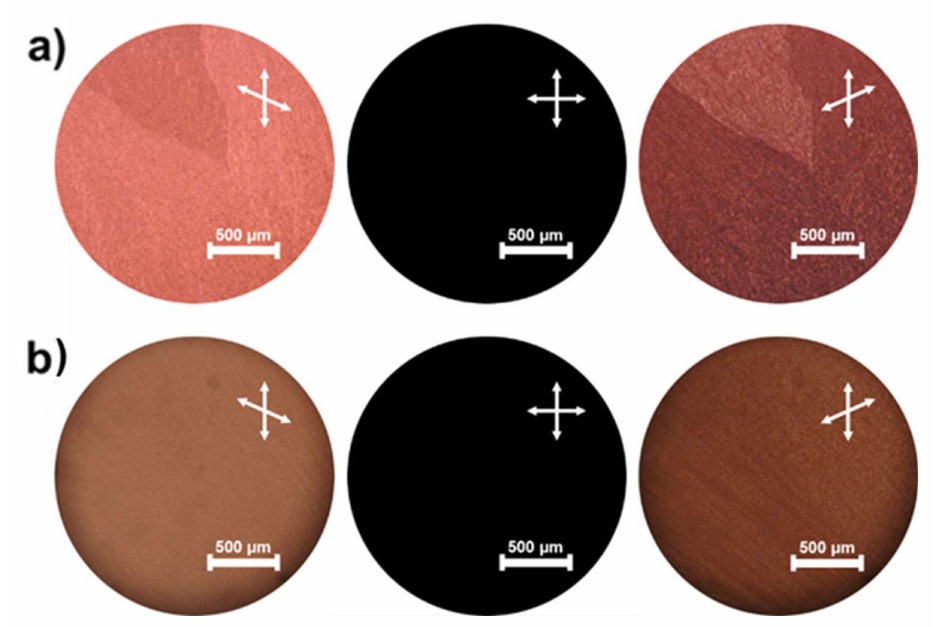
Figure 4. Typical polarized optical microscopy (POM) images of <helical nanofilament (HNF)/ cholesteric> state in P-9 doped with ( a ) CLC-3 and ( b )